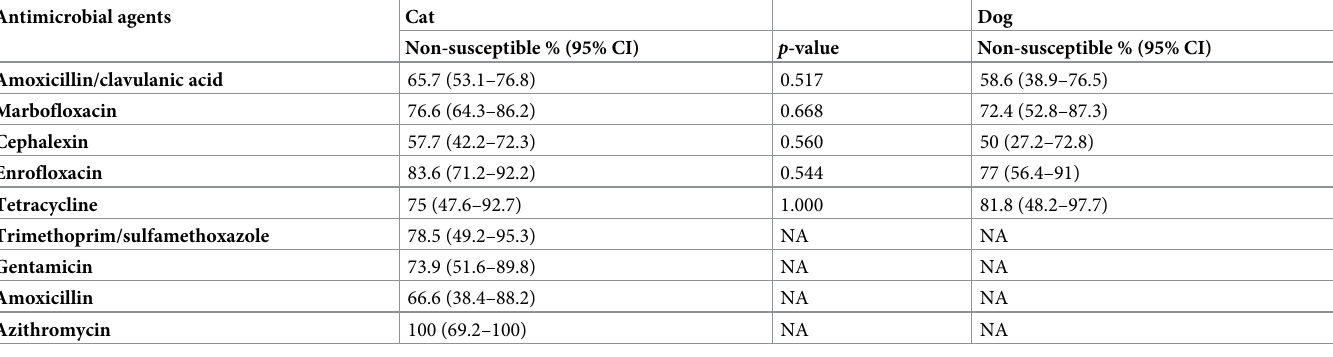
NA- Not Analyzed (data with isolates less than 10 were not